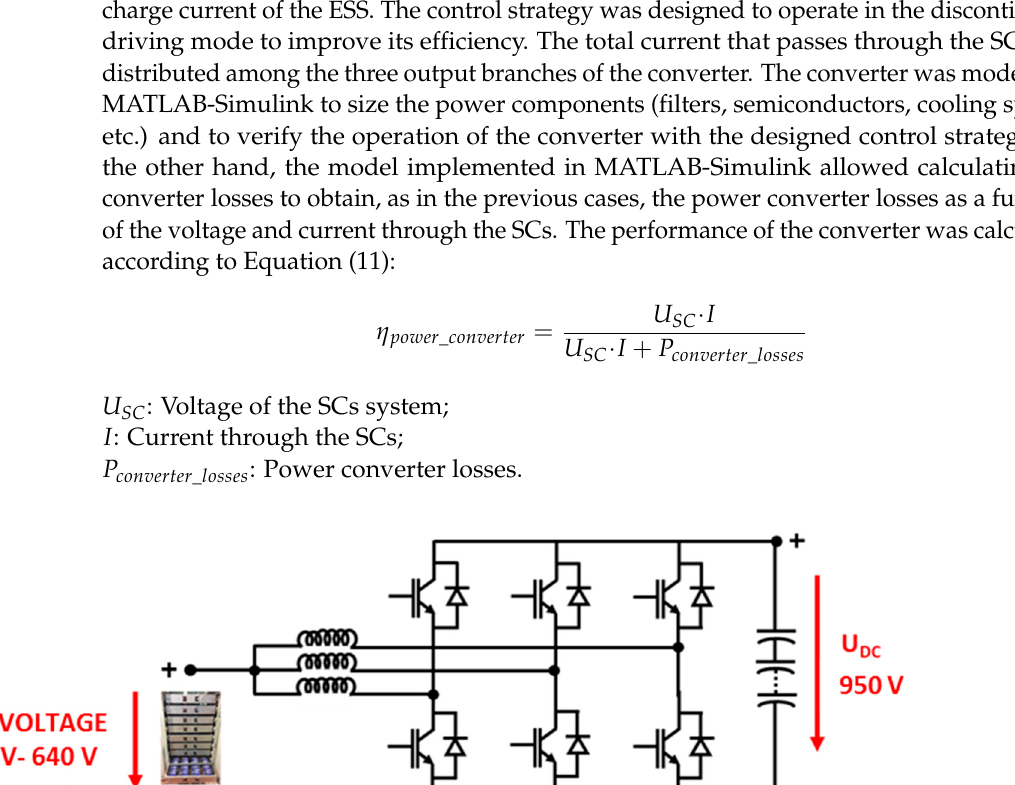
Figure 6. ( a ) Power losses map of the cooling system as a function of voltage and current and ( b ) power losses map in the connection bars between cells as a function of current and voltage.